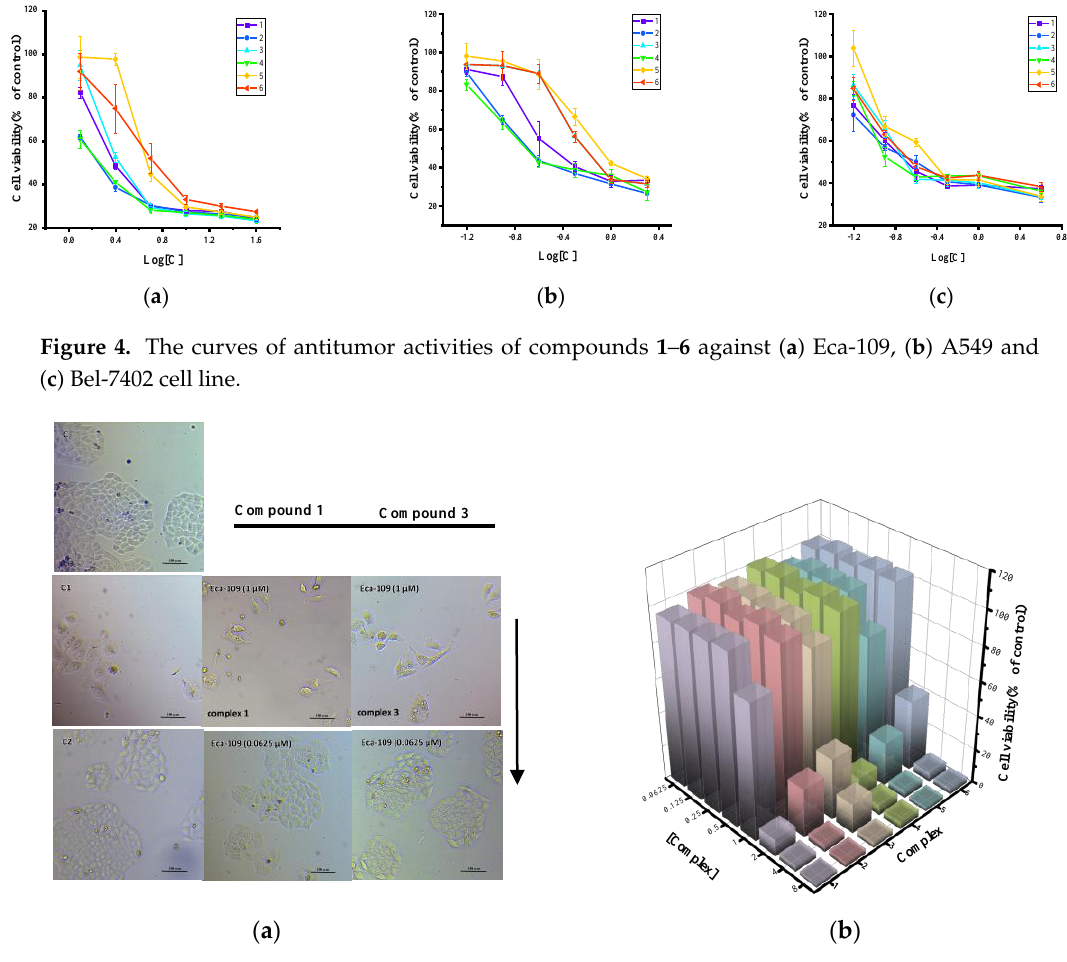
Figure 5. ( a ) Microscopic photographs of Eca-109 cancer cells treated with different concentrations of compound 1 and control photographs (C for blank control group, C1 for 2.5 μM cisplatin, C2 for 20 μM cisplatin). ( b ) The cell viability of compounds 1–6 against RAW264.7.